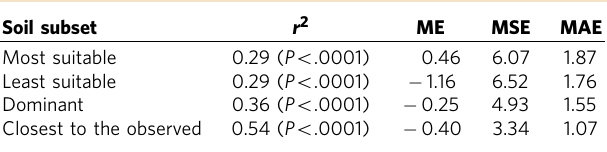
Table 4 | Evaluation of model performance for various soil subsets at the grid cell